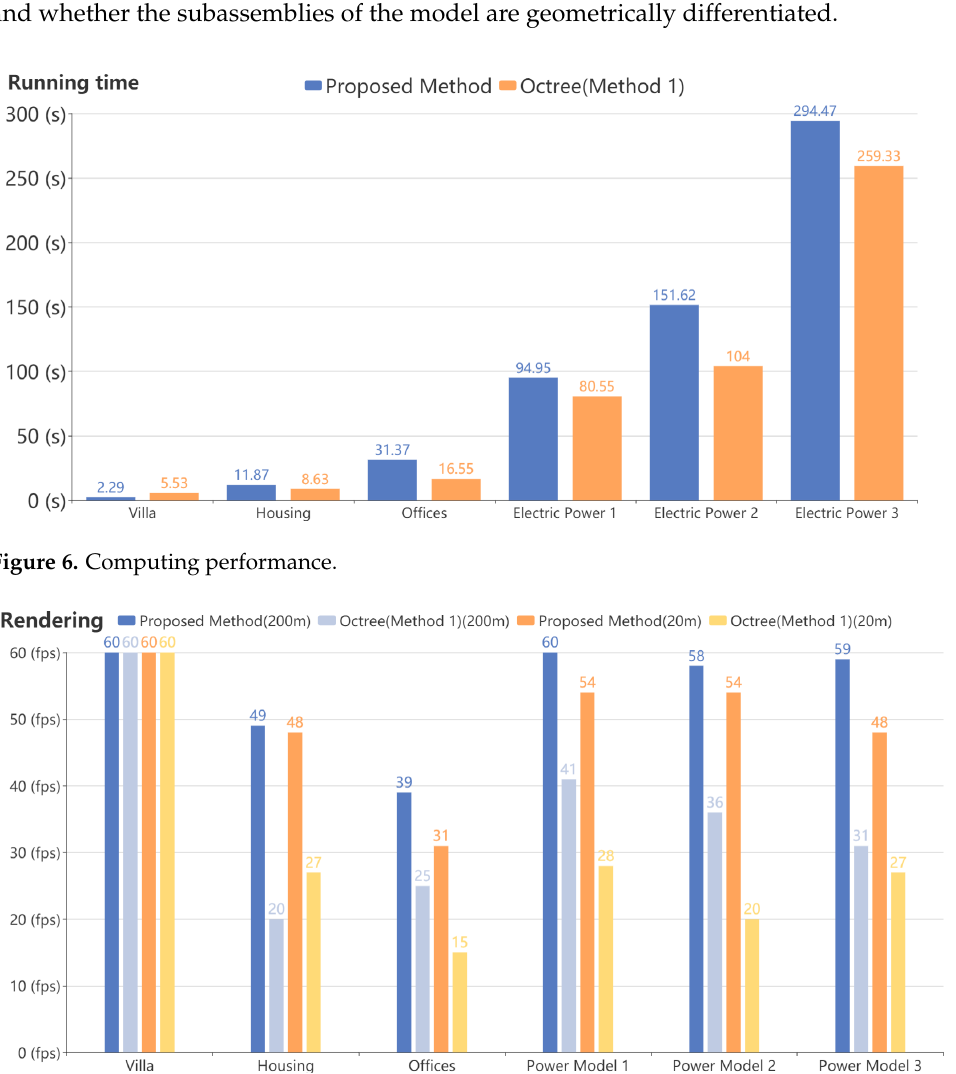
Figure 6. Computing performance.